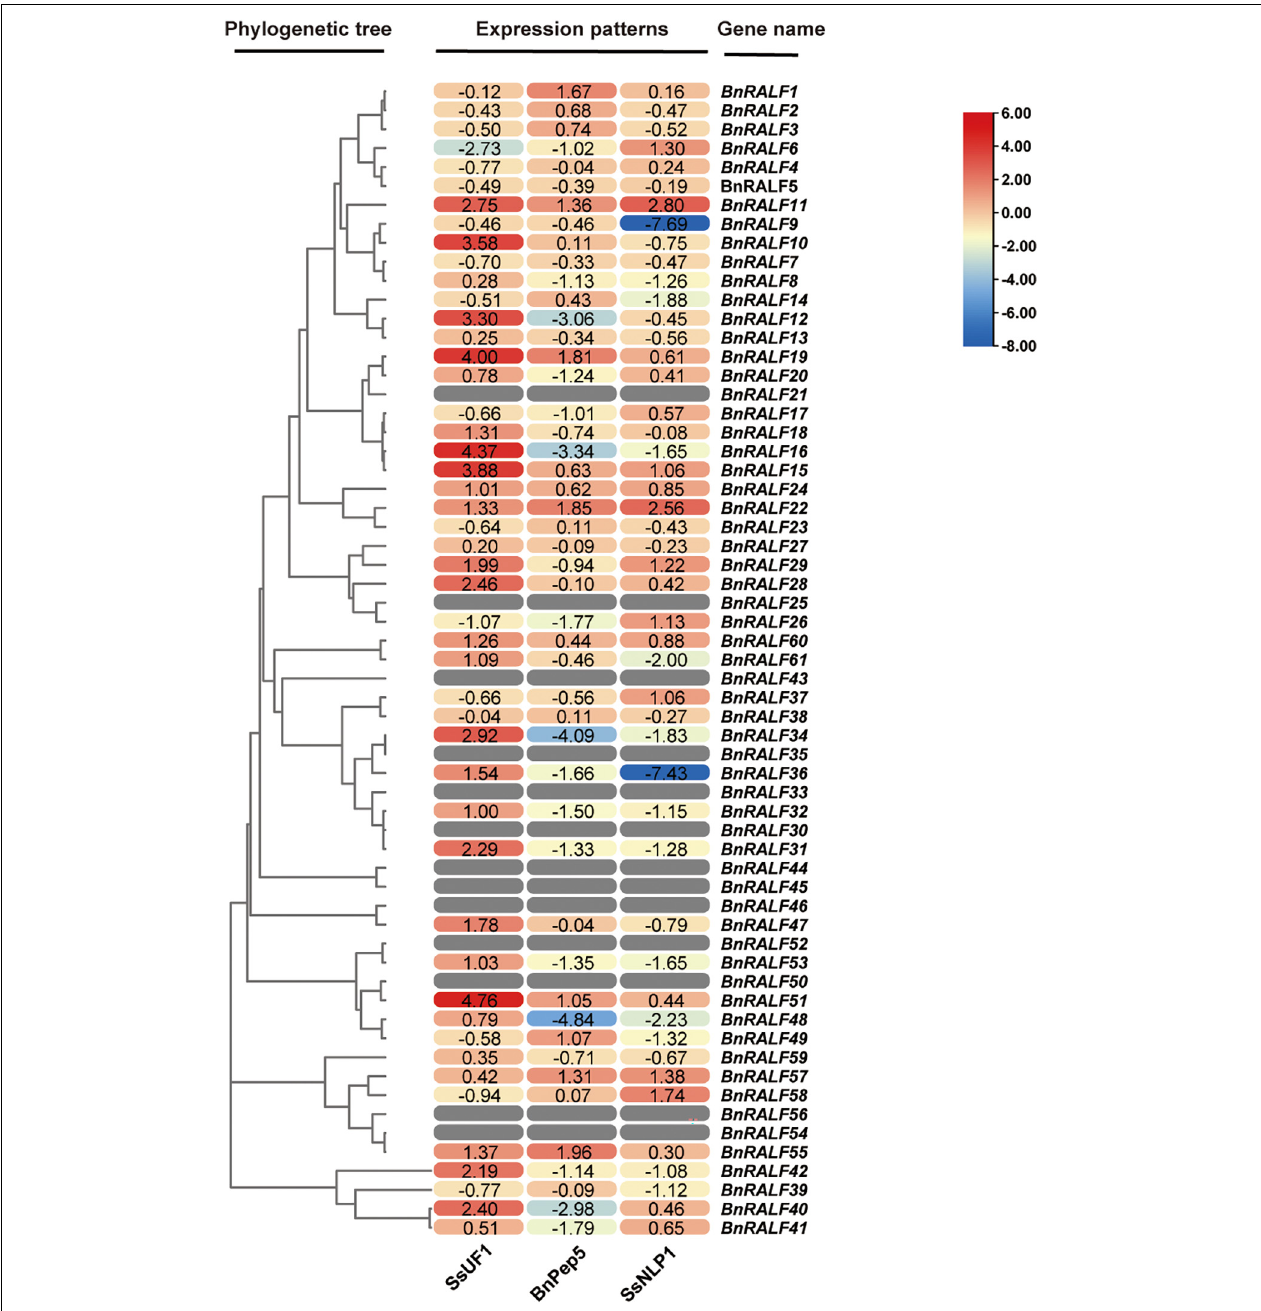
FIGURE 3 | Expression patterns of the whole BnRALF gene family in response to different stimuli. The heatmap was constructed by TBtools to present expression patterns of the 61 BnRALF genes in oilseed rape leaves inoculated with S. sclerotiorum strain UF1 (SsUF1) or infiltrated with 0.2 µ M BnPep5 ( B. napus plant elicitor peptide 5) or 1 µ M SsNLP1 [ S. sclerotiorum ethylene-inducing peptide 1 (SsNep1)-like peptide 1] peptide solution ( n = 3 for each group). PDA plug mock inoculation was served as the control for the SsUF1 inoculation, while ddH 2 O infiltration was conducted as the control for the BnPep5 and SsNLP1 infiltration treatments. The expression levels from low to high are indicated by a change in color from blue to red. The numbers in the figure are represented as log(2)-fold change of treated samples versus mock control. These experiments were performed three times, each yielding similar